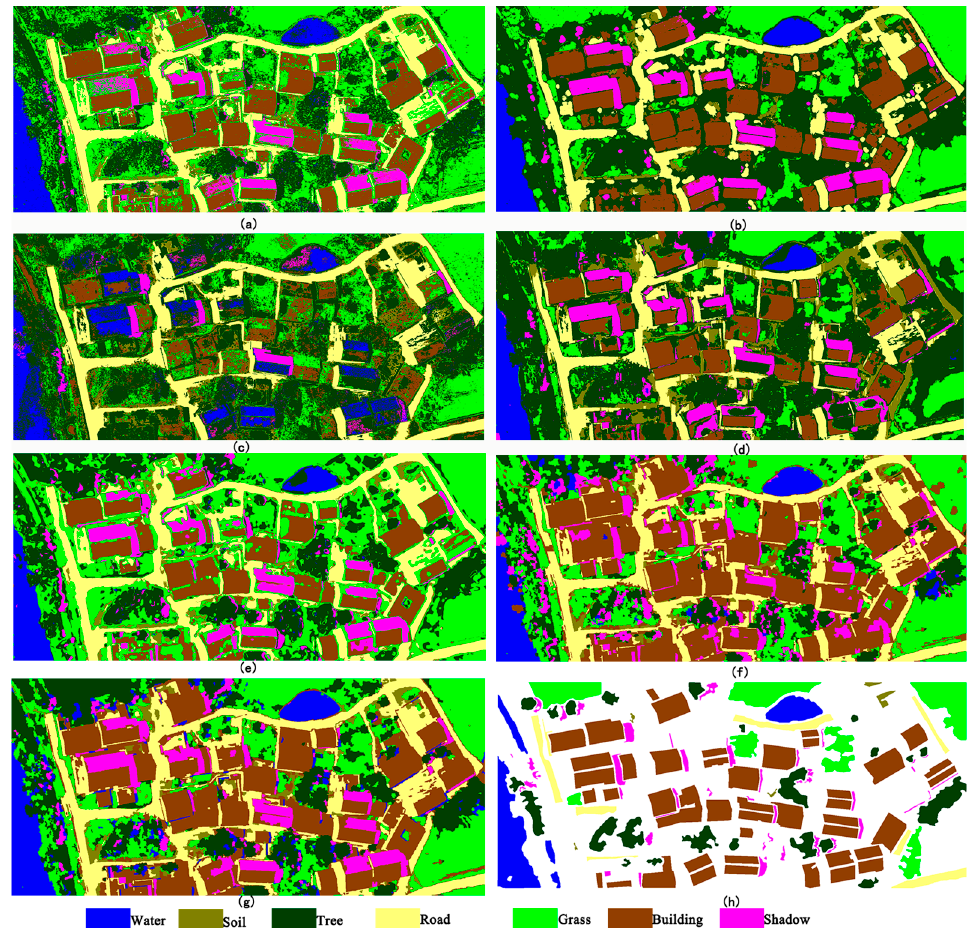
Figure 8. Classification maps from various feature types of UAV image-2 using SVM classifiers: ( a ) spectral feature only; ( b ) M-MP spatial-spectral feature; ( c ) AP spatial-spectral feature; ( d ) RFs Spatial-spectral Feature; ( e ) RGF Spatial-spectral Feature ( f ) proposed object-based, spatial-spectral feature; ( g ) OCI spatial-spectral feature; ( h ) the ground truth. Table 7. Class-specific accuracies (%) for features in SVM classification of UAV image-2.